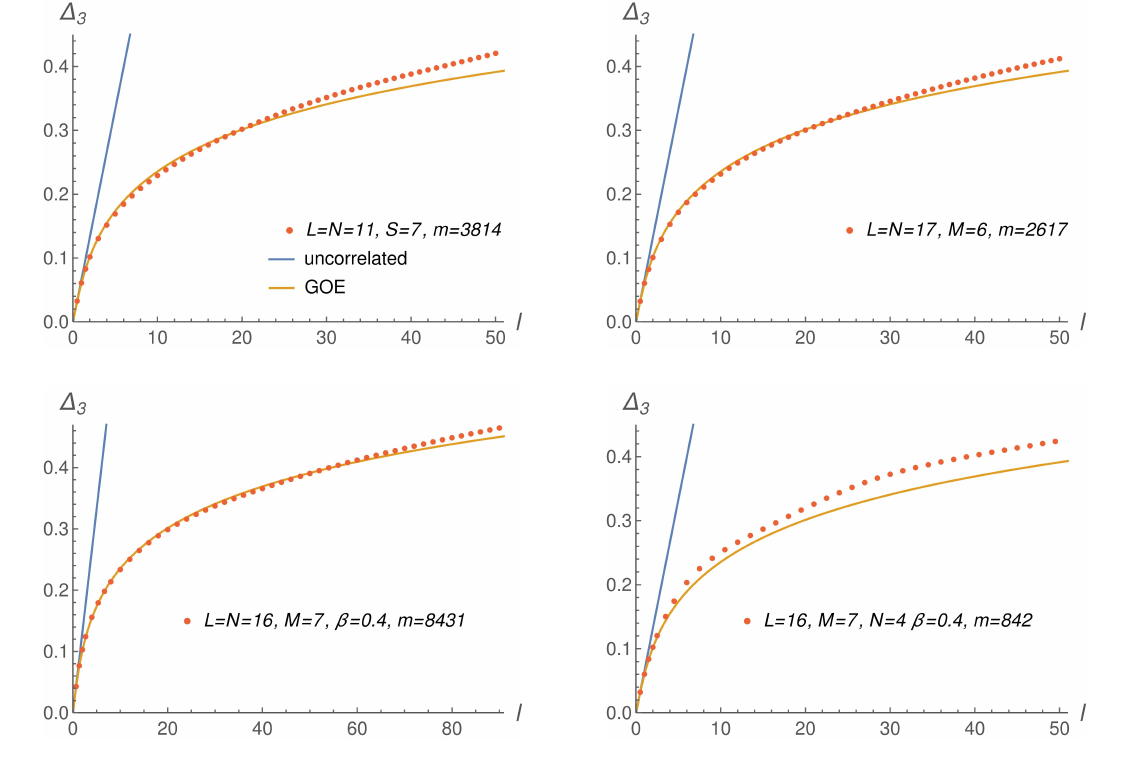
Figure 7: In the top row we depict ∆ for the sl ( 2 ) (left) and su ( 2 ) (right) sectors 3 of N = 4 SYM and observe excellent agreement with the GOE RMT prediction up to l ≈ 25. In the bottom row we plot ∆ for the β -deformed theory at N = 17 (left) and 3 N = 4 (right). The former matches perfectly the expected behaviour up to l ≈ 90, while the latter is close to, but consistently above, the result of the